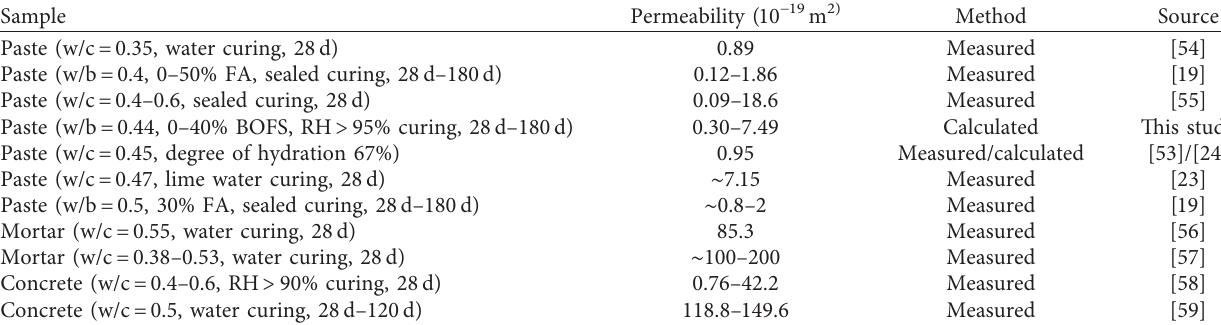
Table 5: Permeability for cement-based materials.